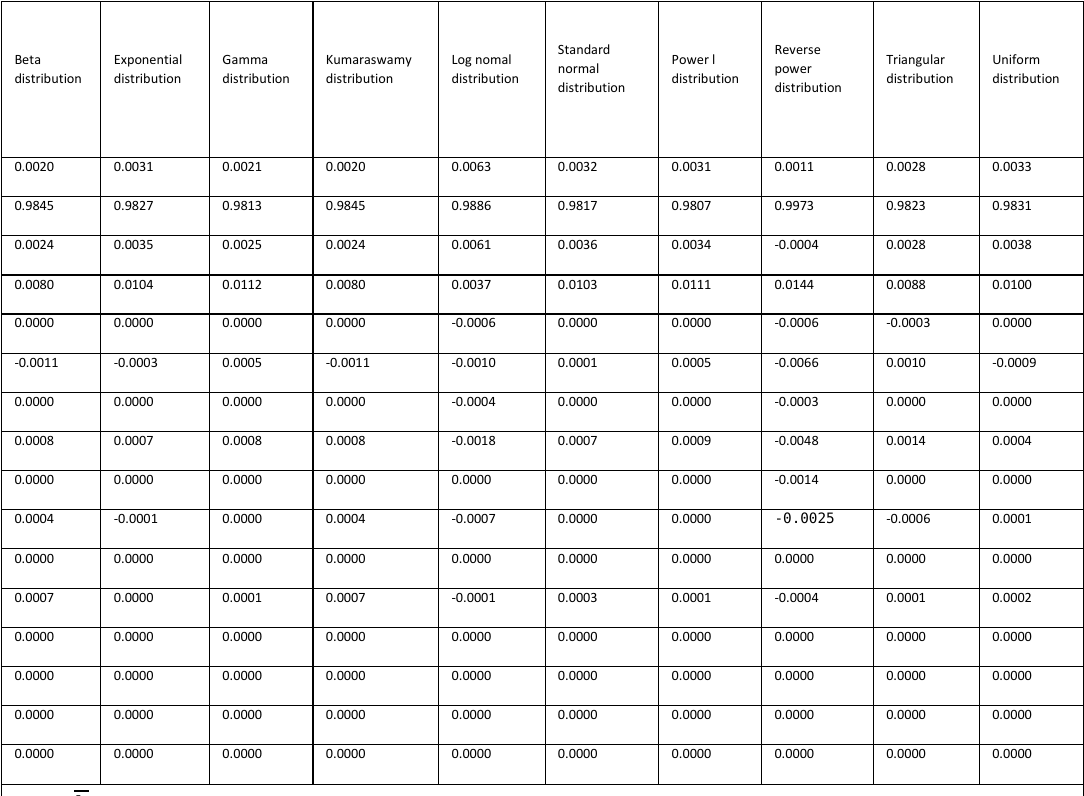
Table 2 Solution: Chebyshev coefficients of K=15 degree